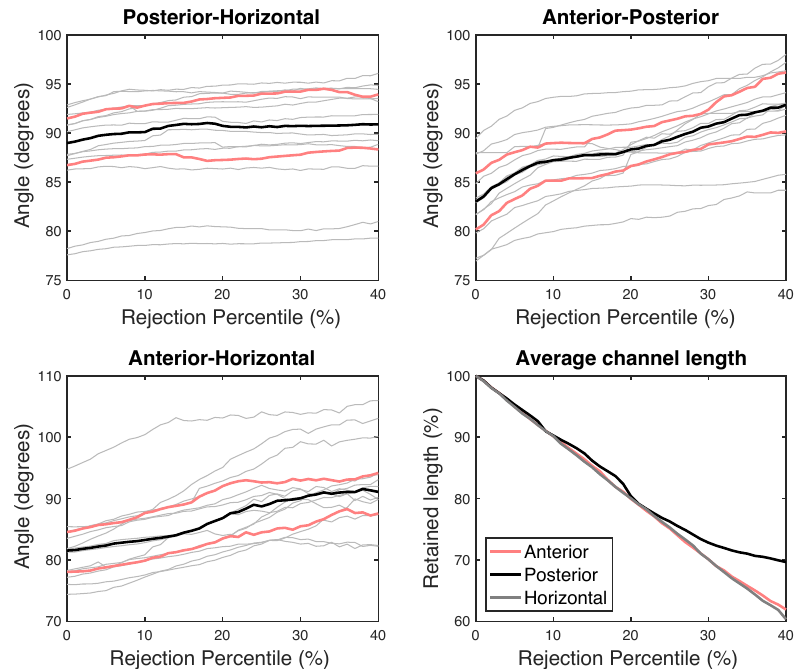
Figure 8. AP, AH and PF pairs angles based on the discarded percentile of the ducts length. Gray lines correspond to different volunteers. The median angle (black thick lines) and the limits defined by the 25th and 75th percentiles (thick red lines) are also presented. The bottom-right panel shows the average channel length as a function of the percentile used for